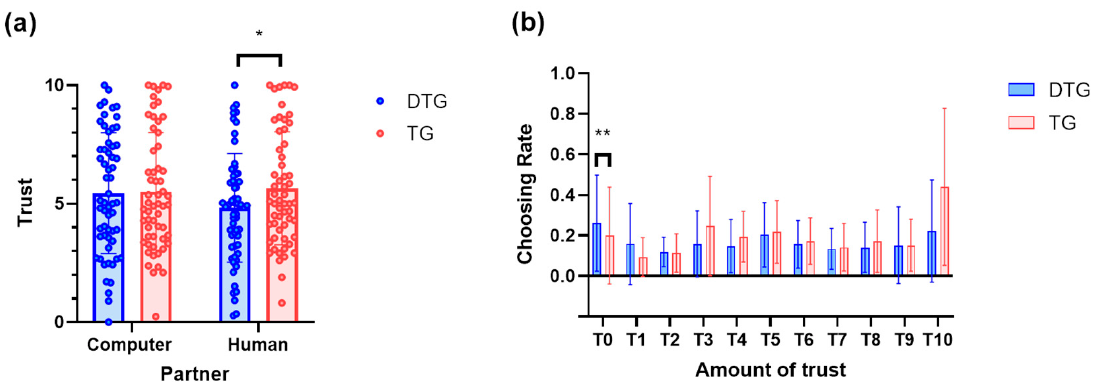
Figure 2. The trust decision in the trust game (TG) and distrust game (DTG) groups. ( a ) Average trust. The mean trust amount (out of Ұ 10) for human and computer-mediated human partners. Bars and error lines indicate the mean values and the standard errors of means. Raw data points are overlaid. ( b ) Average choosing rate. The average choosing rate of each amount of trust across participants when interacting with human partners. Bars and error lines indicate the mean values and the standard deviations. * p < 0.05, ** p < 0.01.